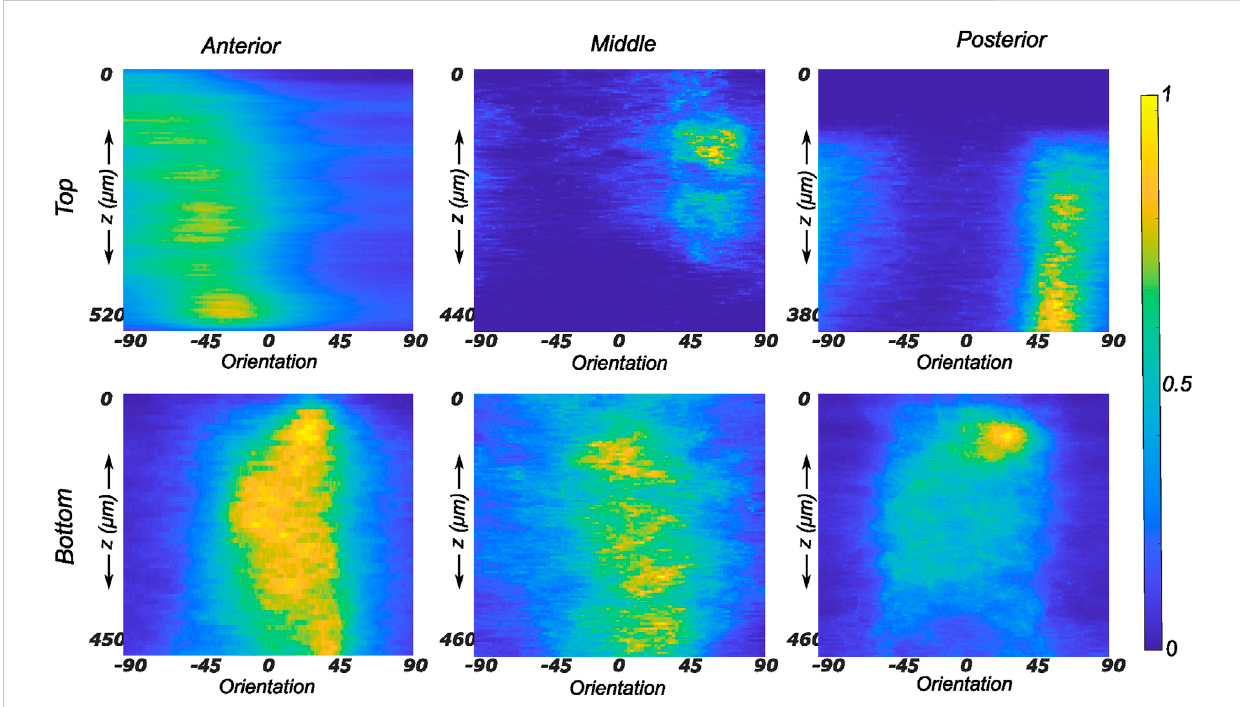
FIGURE 7 Depth pro fi le of collagen fi ber intensity of samples obtained from the medial meniscus. The images recorded on the entire stack were analyzed individually andcompiled togetherinMatlab toproducean intensity plotrepresentativeofthetransmuralvariation incollagen fi bermorphology. Thetop and bottom rows of subplots represent the top and bottom samples, respectively. Column-wise, they represent the anterior, mid-body, and posterior